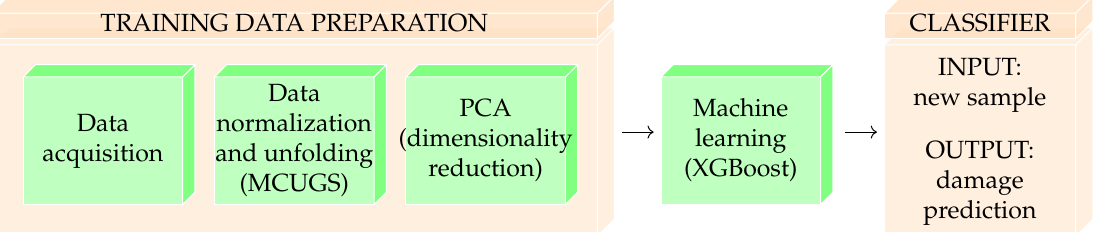
Figure 1. Structural damage classifier construction process.